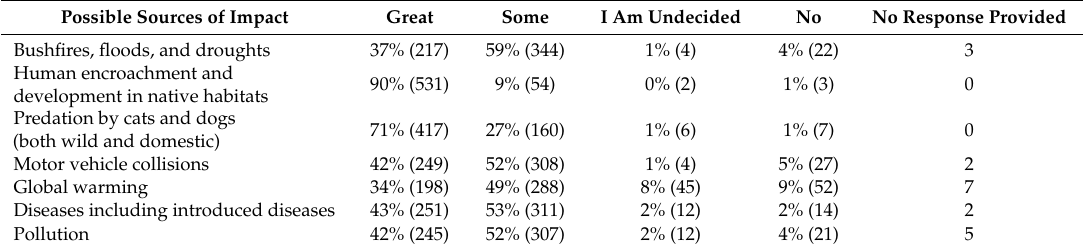
Table 2. Distributions (percentages 1 and numbers) of 590 respondents by responses to the